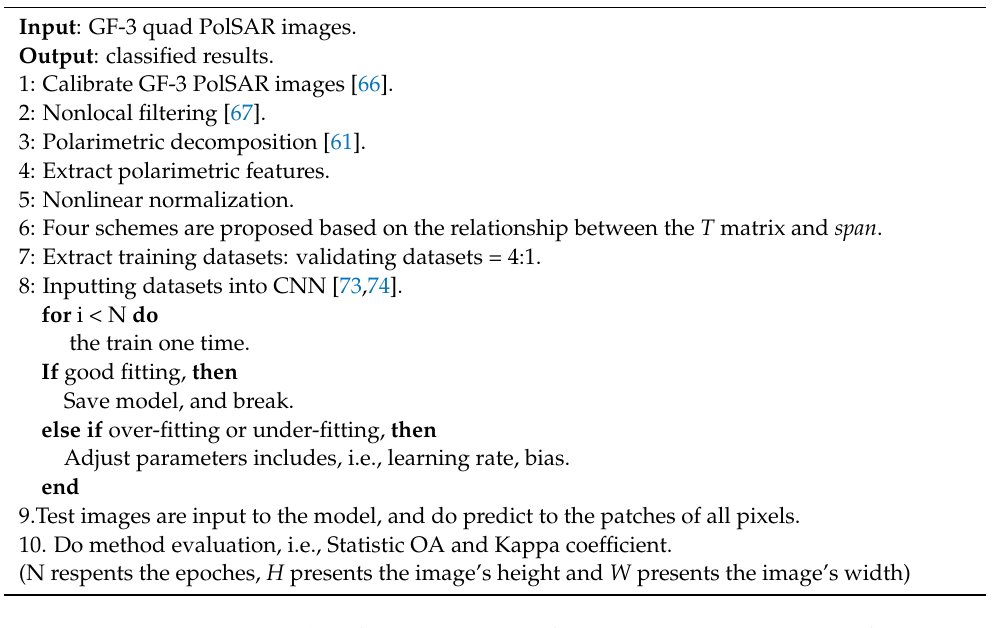
Pseudocodes of the experiment: QP Classification Through CNNs Based on Polarimet- ric Features